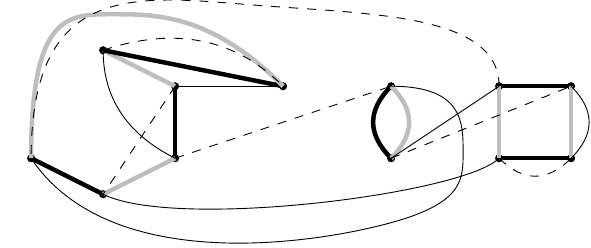
Figure 9 . The graph G 0 = A 0 [ B 0 with P 0 and Q 0 .